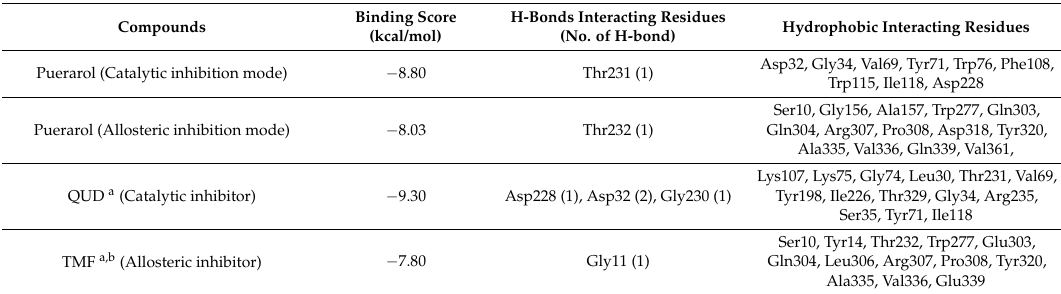
Table 4. Molecular interaction of BACE1 (2WJO) active site with puerarol as well as reported inhibitor QUD and TMF.